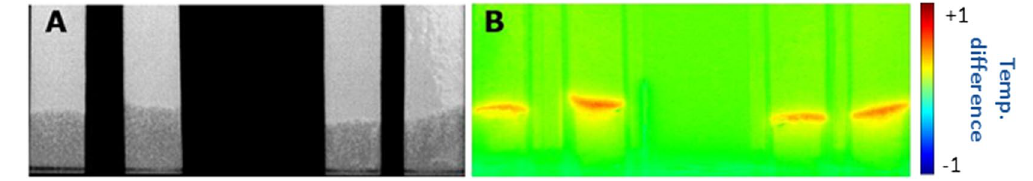
Figure 15. Examples of acquired images: ( A ) optical and ( B ) thermal.